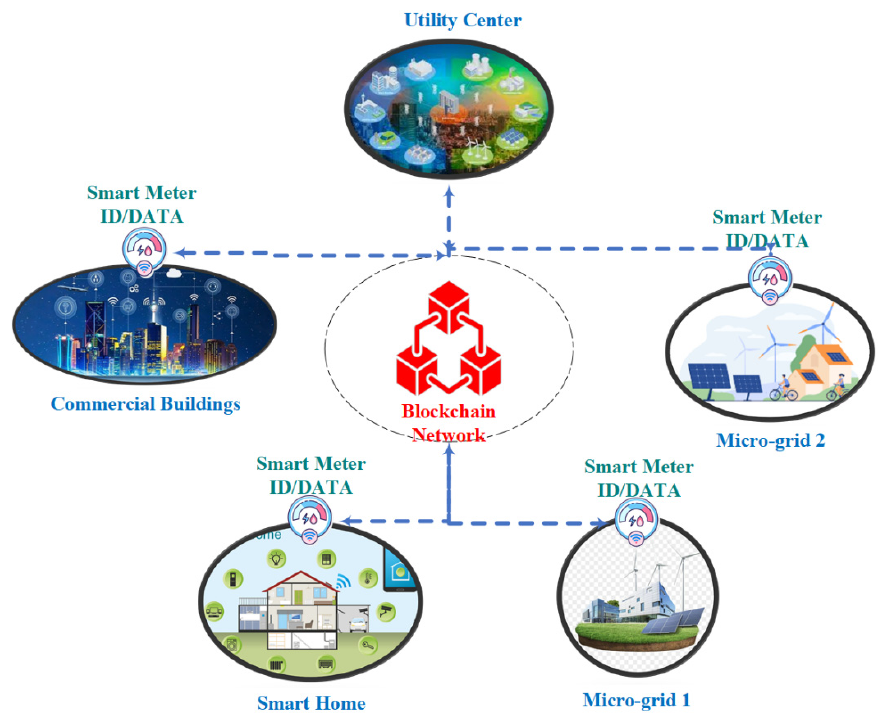
Figure 4. A general approach for integrating blockchain into AMI.